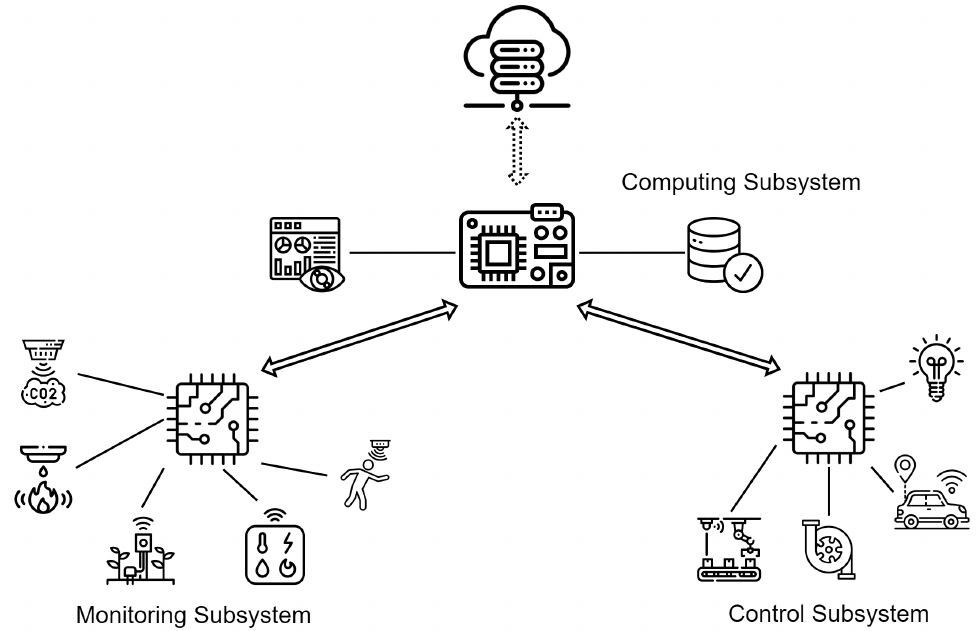
Figure 9. The monitoring and control framework (MCF) showing the three subsystems; monitoring and control subsystems communicating with the computing